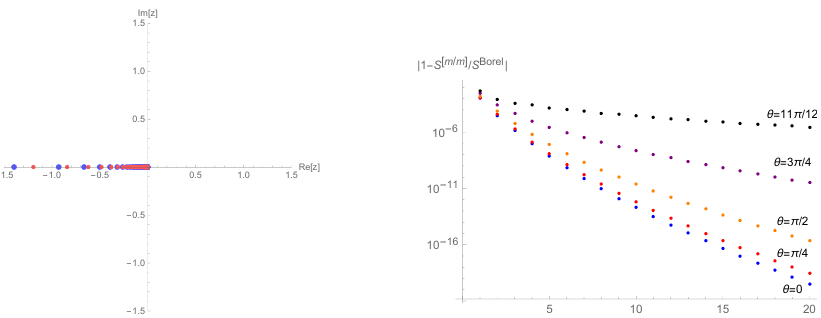
Figure A4. ( Left ) Zeros and poles of the Padé approximant S [ 80/80 ] ( z ) of the Stieltjes series (A156). It implies the branch cut on the negative real axis. This is consistent with the discontinuity of the Borel sum (A157). This branch cut is related to the Stokes phenomenon of the Borel summation. ( Right ) Convergence of the Padé approximants S [ m / m ] ( e i θ /10 ) . As θ gets close to π , the convergence gets